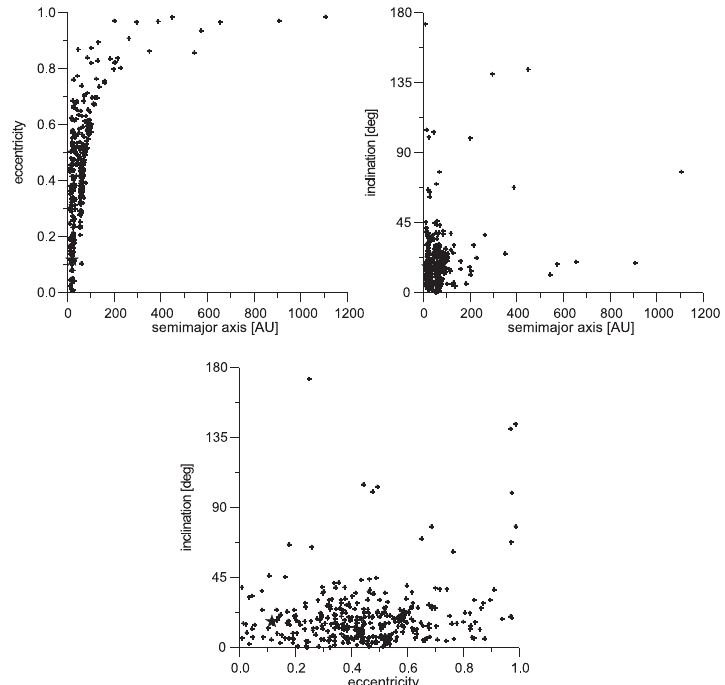
Fig. 3. Positions of all 353 known Centaurs and Scattered-Disk Objects (SDOs) in the MPC list updated on 2012-06-04. The asteroid 2012 DS85 is marked by a star symbol. H = 9.429 mag, with the r.m.s. = 0.316 mag. Using a typical albedo of